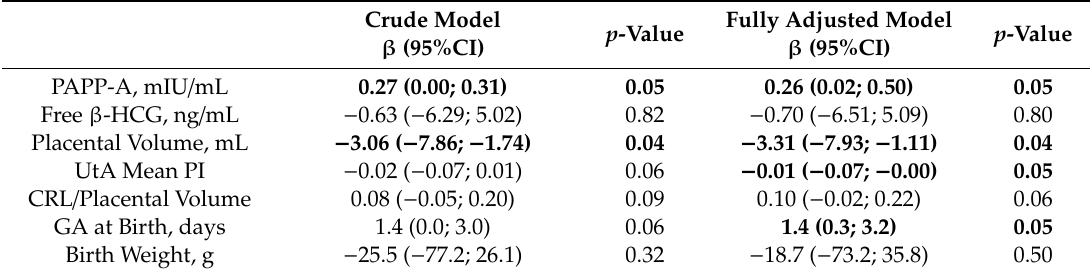
Table 4. Results from multi-adjusted general linear models on the associations between nutritional score (independent variable), first trimester biochemical and ultrasound markers of placental function, and pregnancy outcomes (dependent